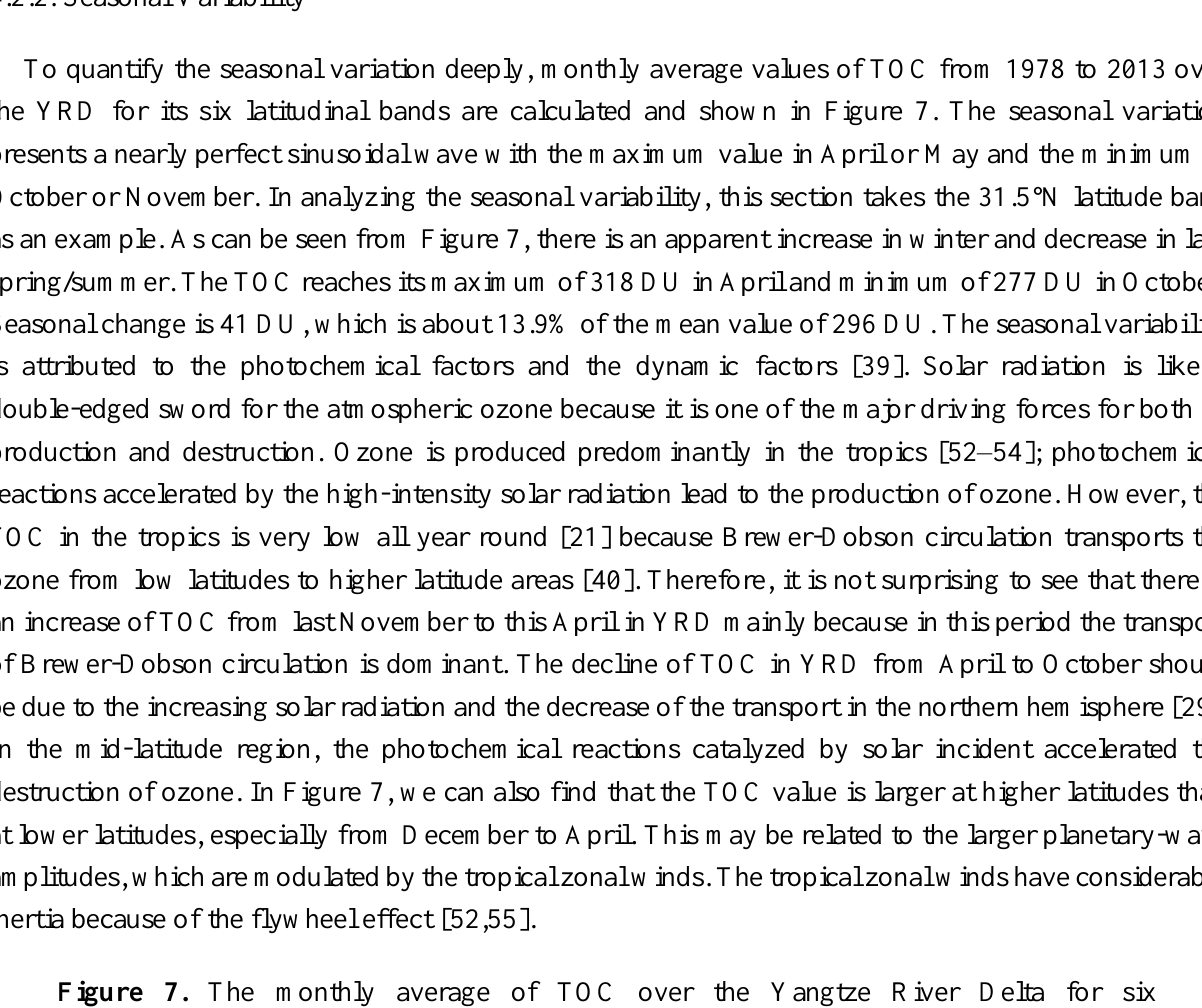
Figure 7. The monthly average of TOC over the Yangtze River Delta for six latitudinal